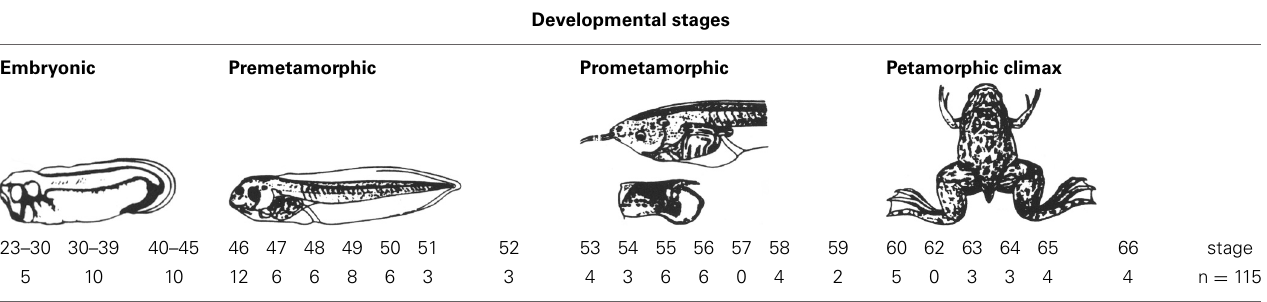
Table 1 | Number of animals investigated at different stages of development for Pax7